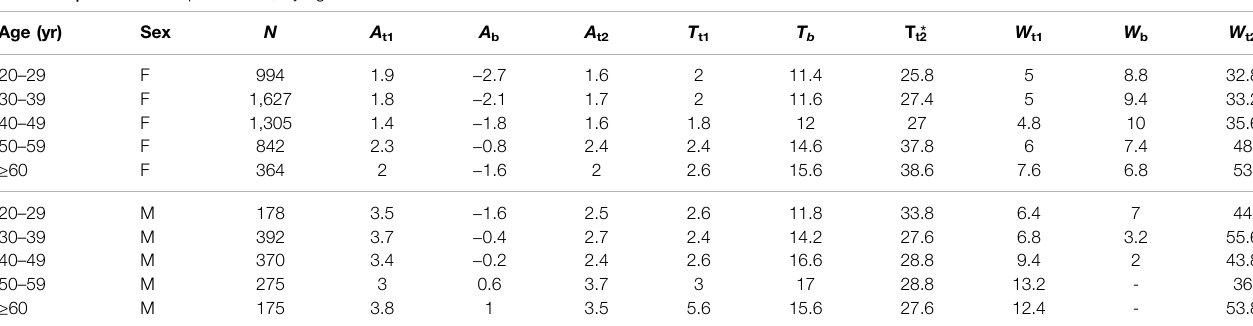
TABLE 4 | Estimation of parameters, by age.